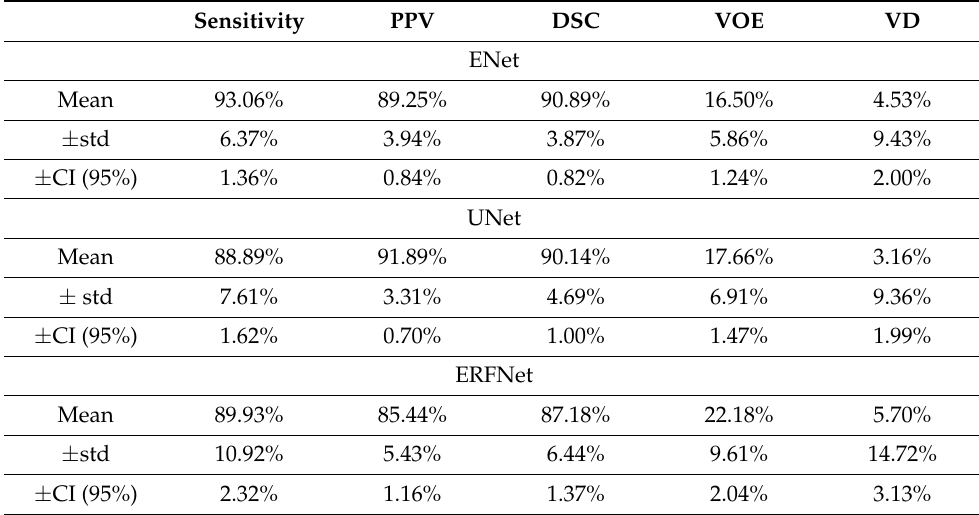
Table 3. Performance segmentation using the ENet, UNet, and ERFNet methods.